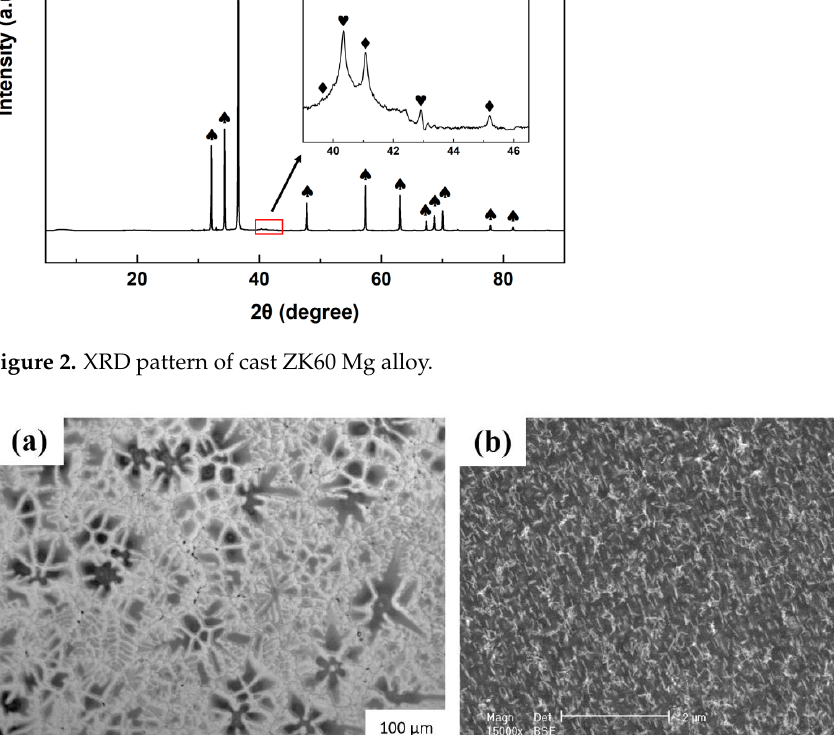
Figure 3. ( a ) Metallograph and ( b ) SEM image of cast ZK60 Mg alloy.